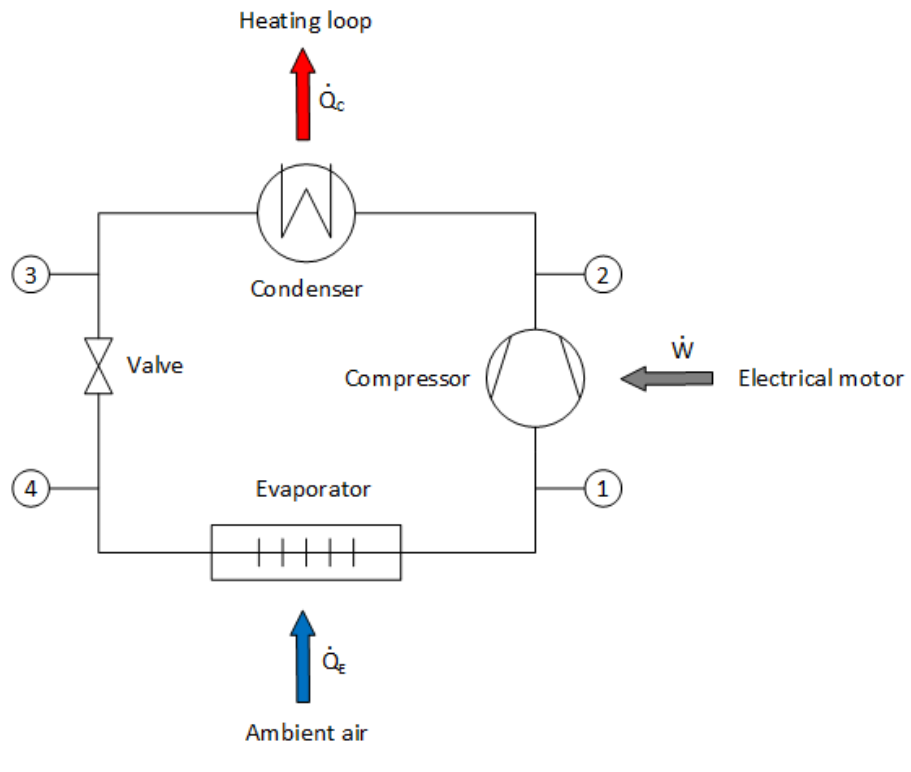
Figure 3. Layout of the heat pump.